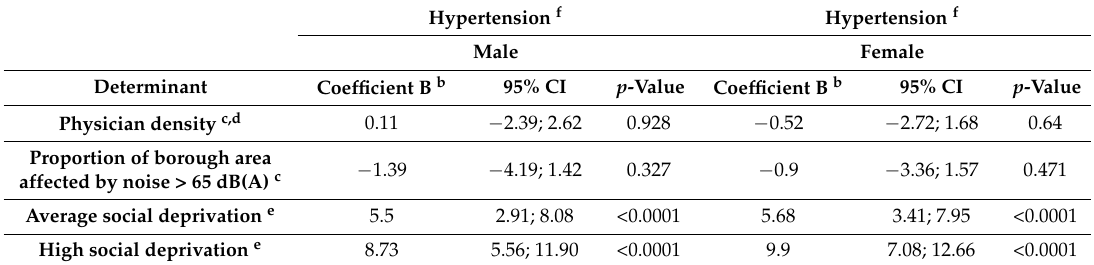
Table 5. Associations of determinants on hypertension, Hamburg, Germany a .